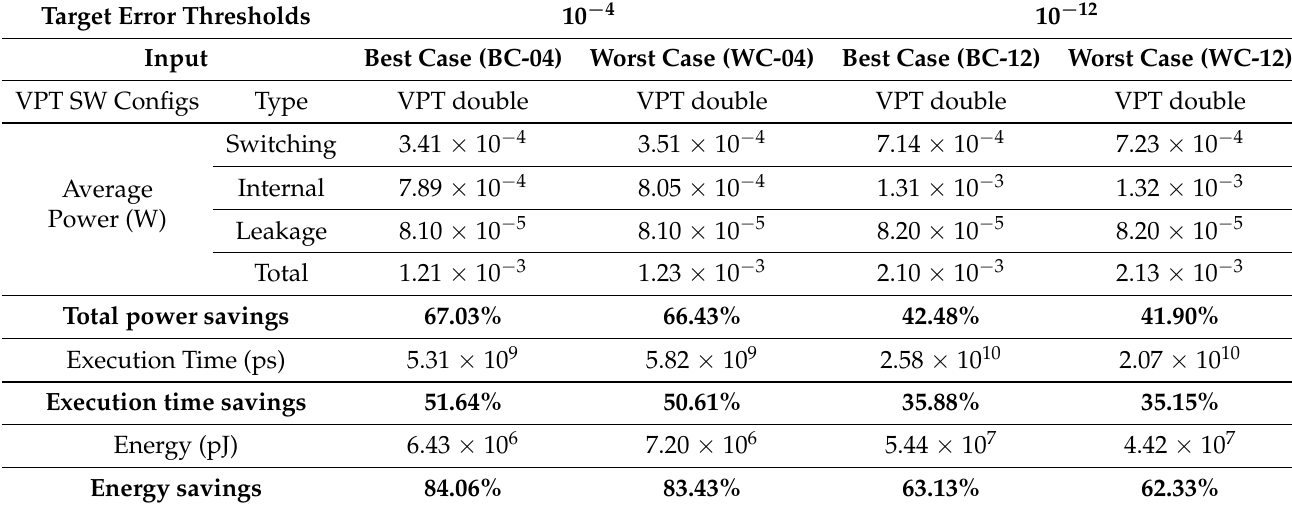
Table 5. Power, execution time, and energy consumption gains of VPT-enabled version of Jacobi (with theoretical conserva- tive thresholds) executed on the VPT_H configuration of the